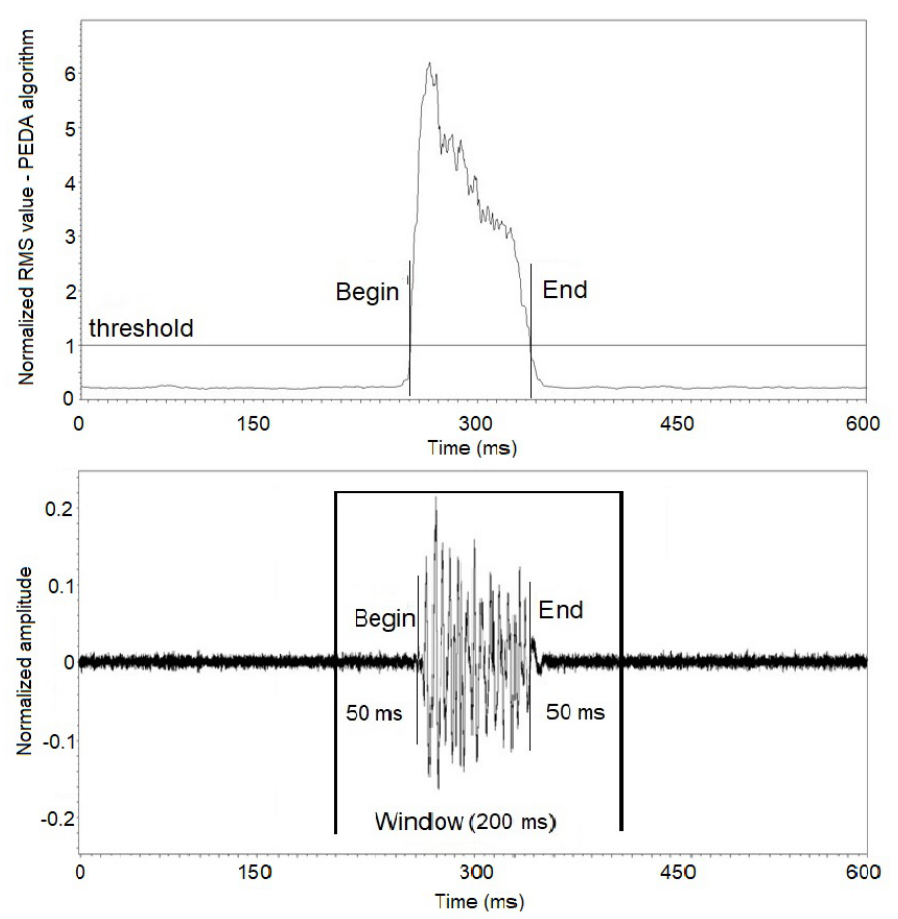
Figure 12. Stored signal window based on insect passage